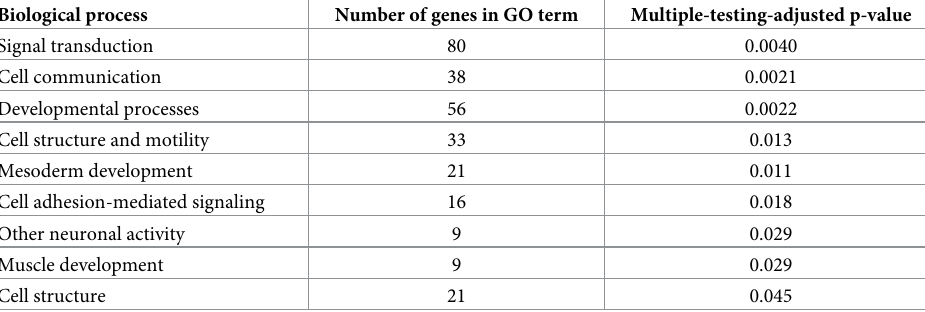
Table 2. Significant GO terms for the top 300 genes that distinguish primary from cutaneous melanoma.